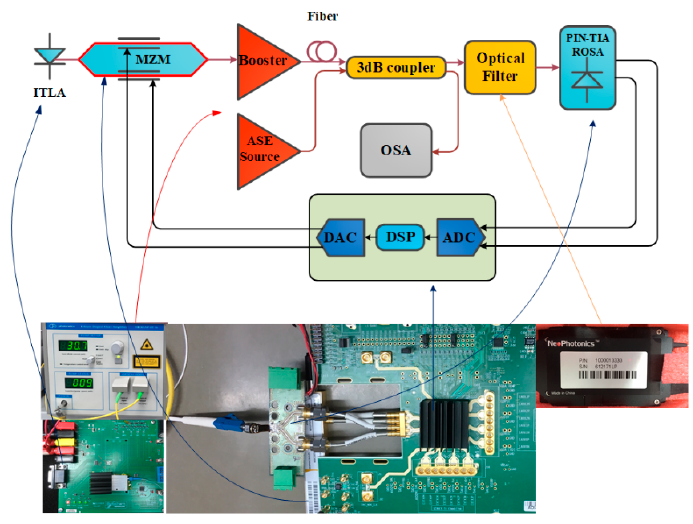
Figure 3. Lab measurement setup.